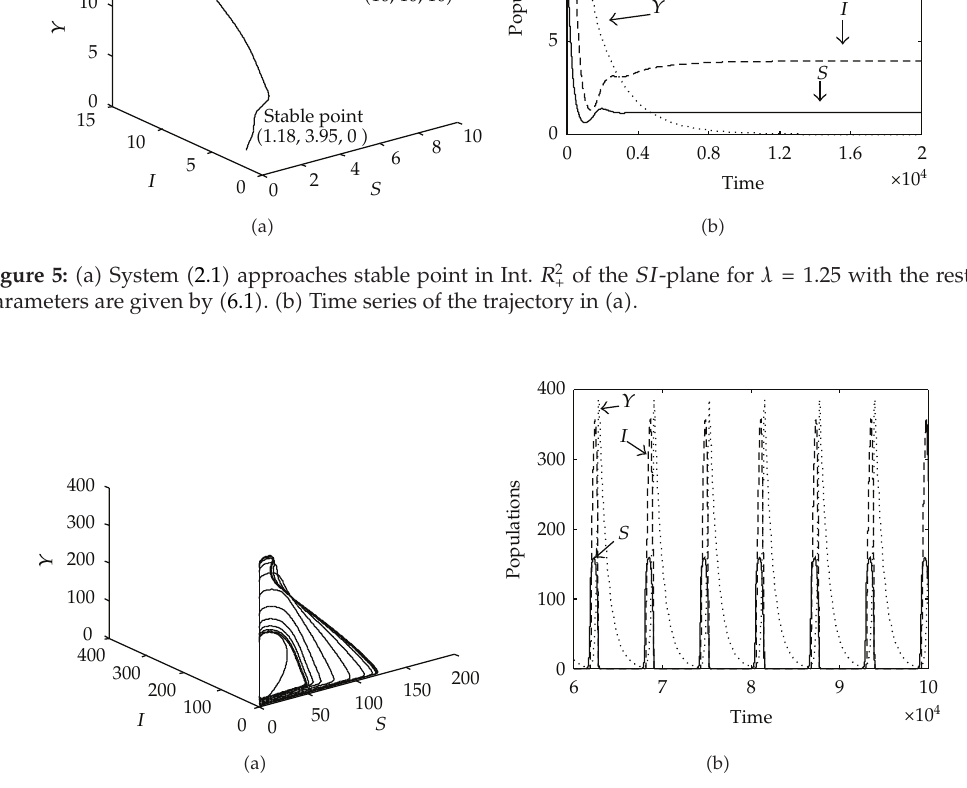
Figure 6: (cid:5) a (cid:6) System (cid:5) 2.1 (cid:6) approaches periodic attractor in Int. R 3 (cid:7) for r (cid:8) 1 . 55 with the rest of parameters are given by (cid:5) 6.1 (cid:6) . (cid:5) b (cid:6) Time series of the trajectory in (cid:5) a (cid:6)